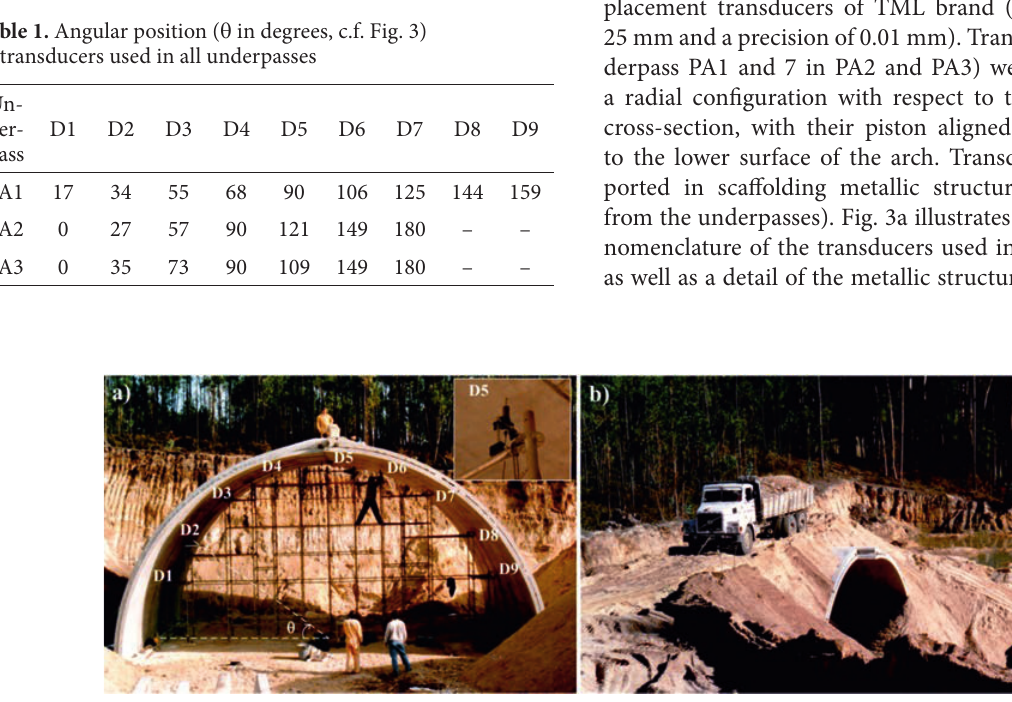
Fig. 3. Load test of underpass PA1: a – general view and nomenclature of transducers; b – test in